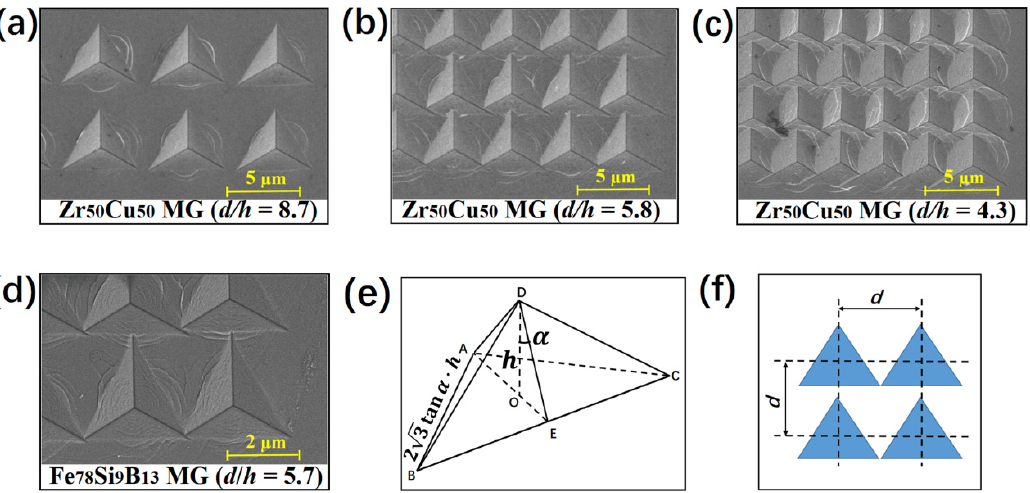
Figure 5. Geometric analysis of the indent array in the nanoindentation mapping. ( a – c ) Scanning electron microscopy images of the indent array on the Zr 50 Cu 50 metallic glass with d / h = 8.7, 5.8, and 4.3, respectively. ( d ) Scanning electron microscopy image of the indents on Fe 78 Si 9 B 13 metallic glass after nanoindentation mapping with d / h = 5.7. ( e ) Schematic of the Berkovich indenter tip. OD is the height h of the tri-pyramid ABCD, which indicates the indenting displacement beneath the sample surface, and Δ ABC is an equilateral triangle. ∠ ODE is the processing angle α of the standard Berkovich tip, which was ~65.3°. ( f ) Schematic of the critical spacing distance when the indentations started overlapping.